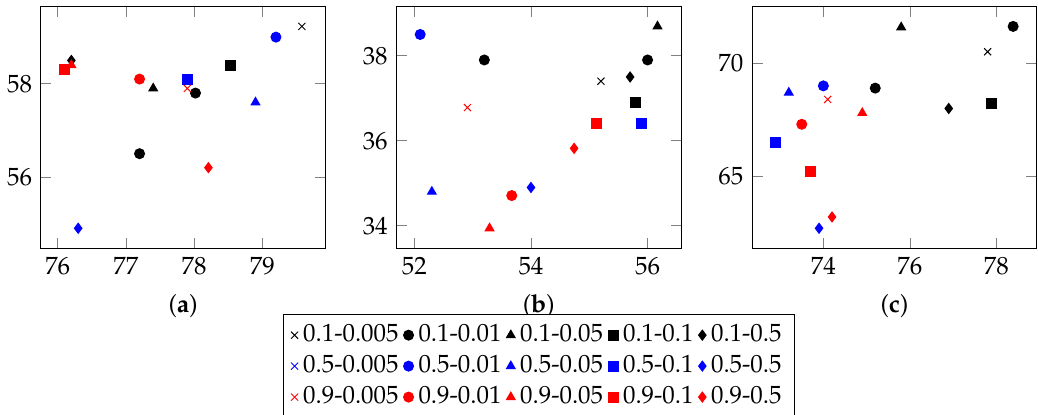
Figure 6. Selection α and β . Correctness-Conciseness scatter diagrams used to compare the quality of inferring ( a ) FTP message formats; ( b ) CoAP message formats; ( c ) XMPP message formats.